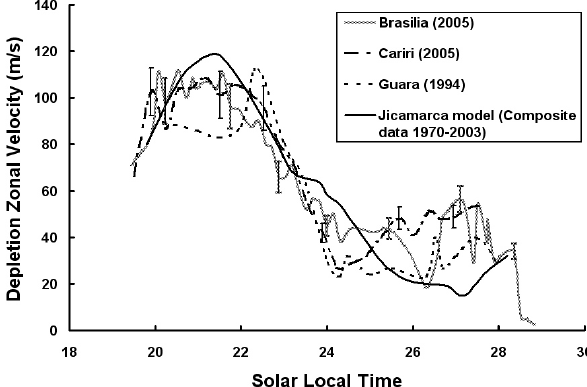
Fig. 5. Comparison of the average EPB phase velocities from Brasilia and Cariri, during the SpreadFEx campaign, using 17 and 19 nights, respectively, with an empirical model derived from the Jicamarca radar measurements by Fejer et al. (1991), and previous observations from Alcantara, Brazil, by Taylor et al.